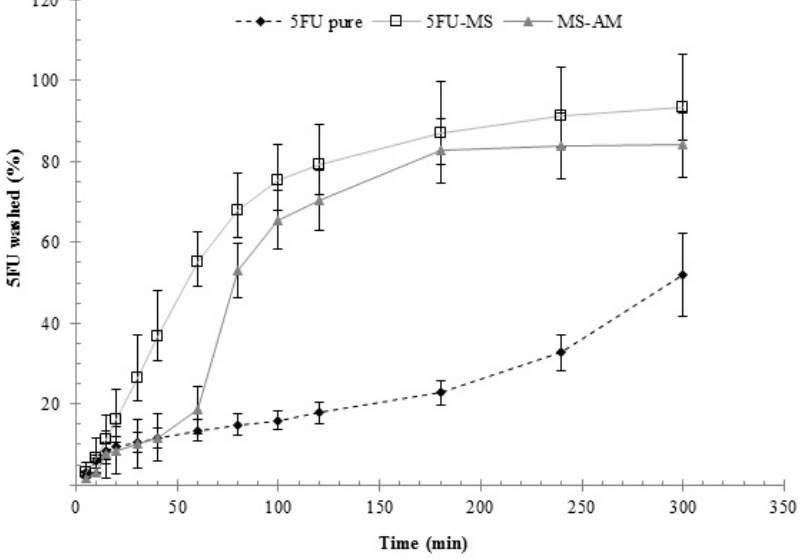
Figure 8. Washability profiles (0–300 min) of 5FU-MS formulation, MS-AM powder, and drug 5FU pure.